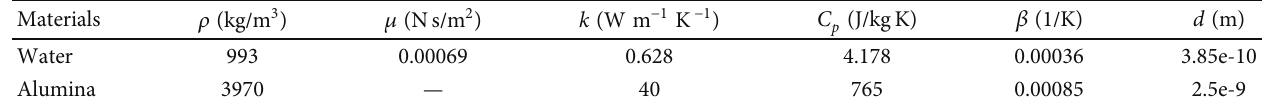
Table 1: The materials used and their thermophysical properties